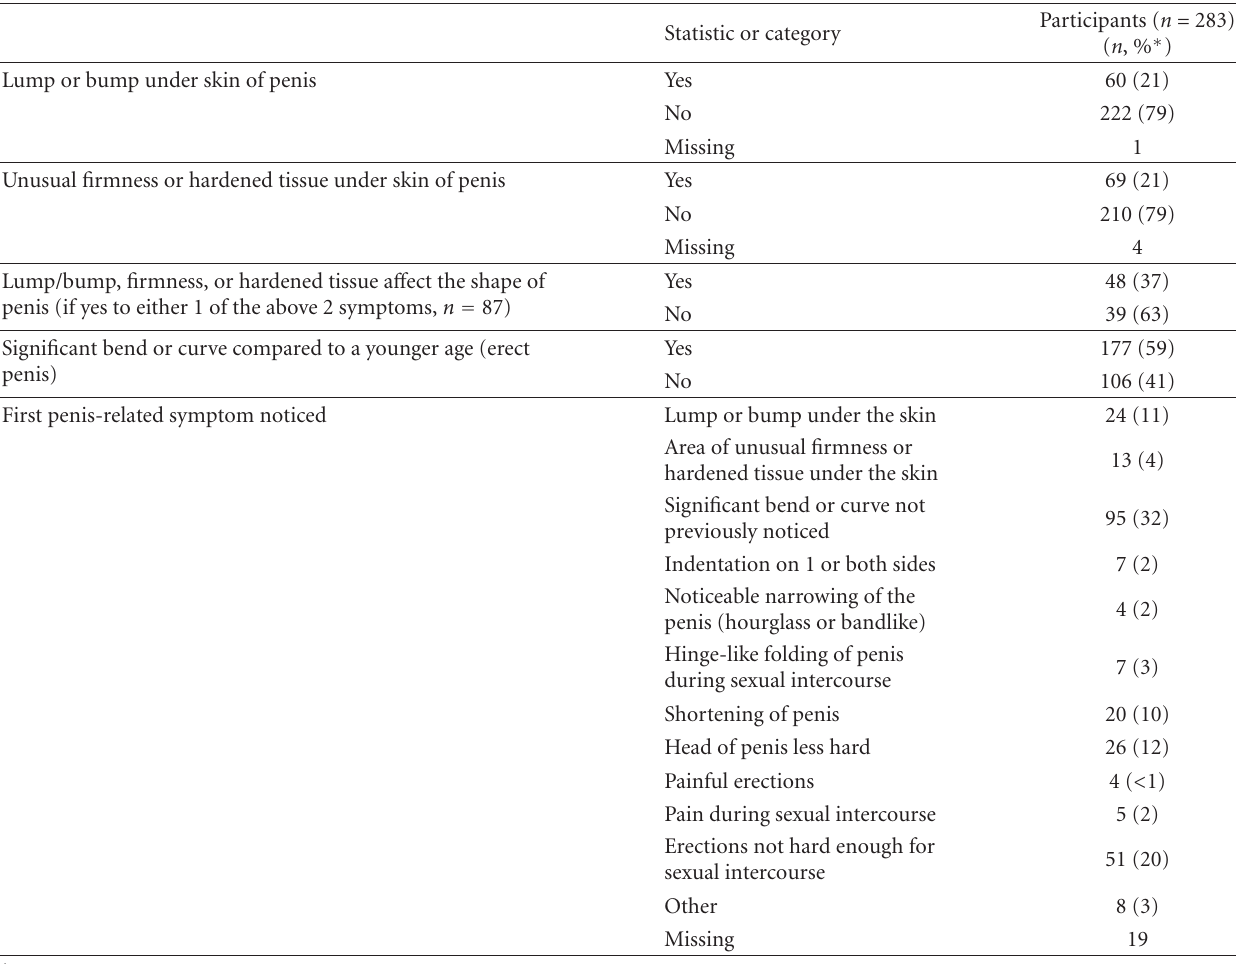
Table 4: Summary of Peyronie’s disease symptoms in participants with symptoms, treatment, or diagnosis ( n = 283). Statistic or